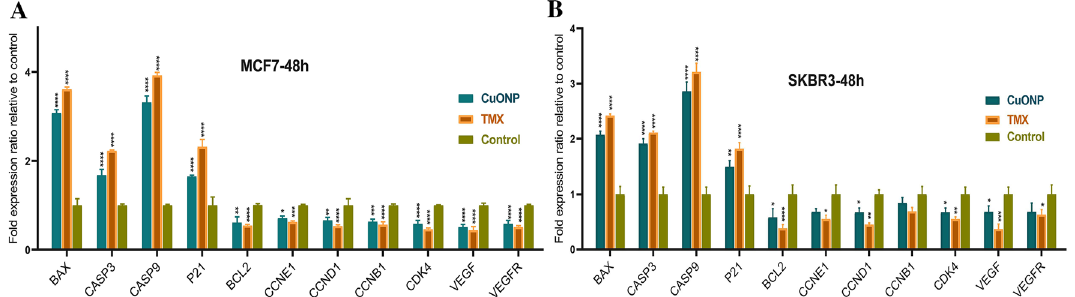
Figure 11. BAX, BCL2, CASP3, CASP9, P21, VEGF, VEGFR, CCND1, CCNE1, CCNB1, CDK4 , and ACTB expression levels in ( A ) MCF7 and ( B ) SKBR3 cell lines treated with IC 50 concentration of BC-CuONPs and tamoxifen (TMX) after 48 h. (*: P < 0.05, **: P < 0.01, ***: P < 0.001, and ****: P <